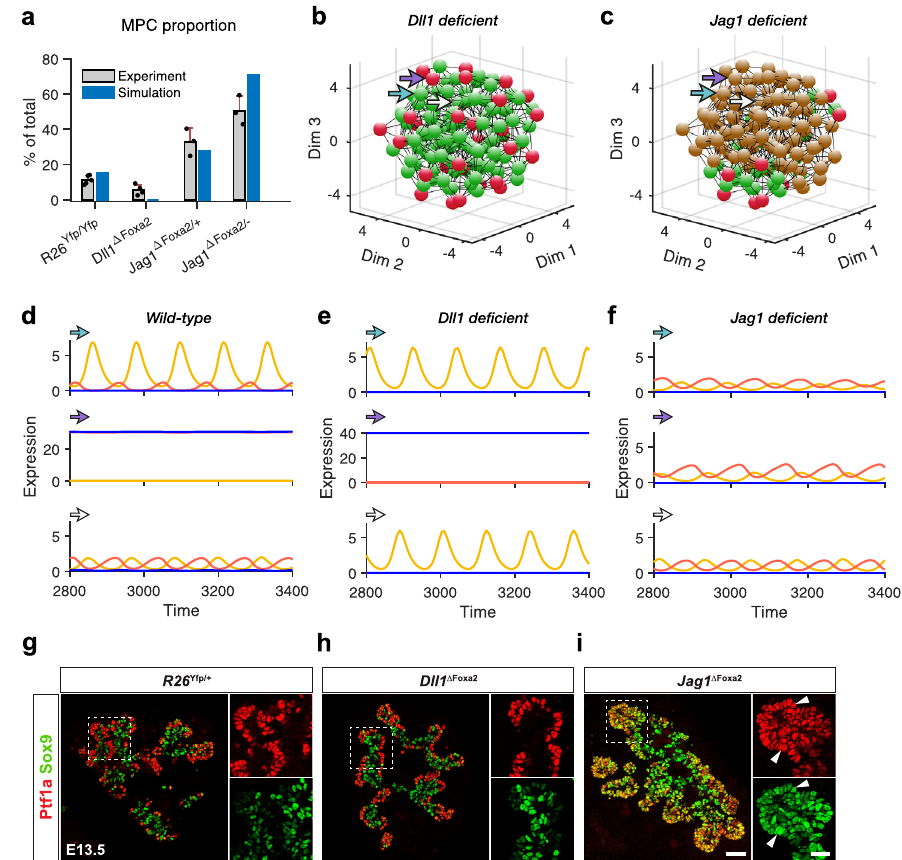
Fig. 5 | Jag1 plays pivotal role in pancreatic development. a Dll1 de fi ciency facilitates while Jag1 de fi ciency hampers MPC differentiation. Compared with wild type ( R26 Yfp/Yfp ), Dll1 de fi cient ( Dll1 Δ Foxa2 ) mutants show decreased MPC proportion in E12.5 pancreas. Intermediate Jag1 de fi ciency ( Jag1 Δ Foxa2/+ ) and severe Jag1 de fi - ciency ( Jag1 Δ Foxa2/ − ) increased MPC proportions in E12.5 pancreas. Gray bars: experimentalMPCproportionsofpancreasindifferentmutants,mean±SDofdata in ref. 16 is plotted. N = 5 for R26 Yfp/Yfp controls, N = 4 for Dll1 mutants, N = 3 for Jag1 heterozygous mutants, N = 3 for Jag1 homozygous mutants. Blue bars: predicted MPC proportions of different simulated genotypes with in silico pancreas. b , c Spatialpositionsofthreecellfatesin Dll1 de fi cientpancreasand Jag1 de fi cient pancreas. Cell fates are de fi ned with the expression of Ptf1a and Hes1 at the fi nal